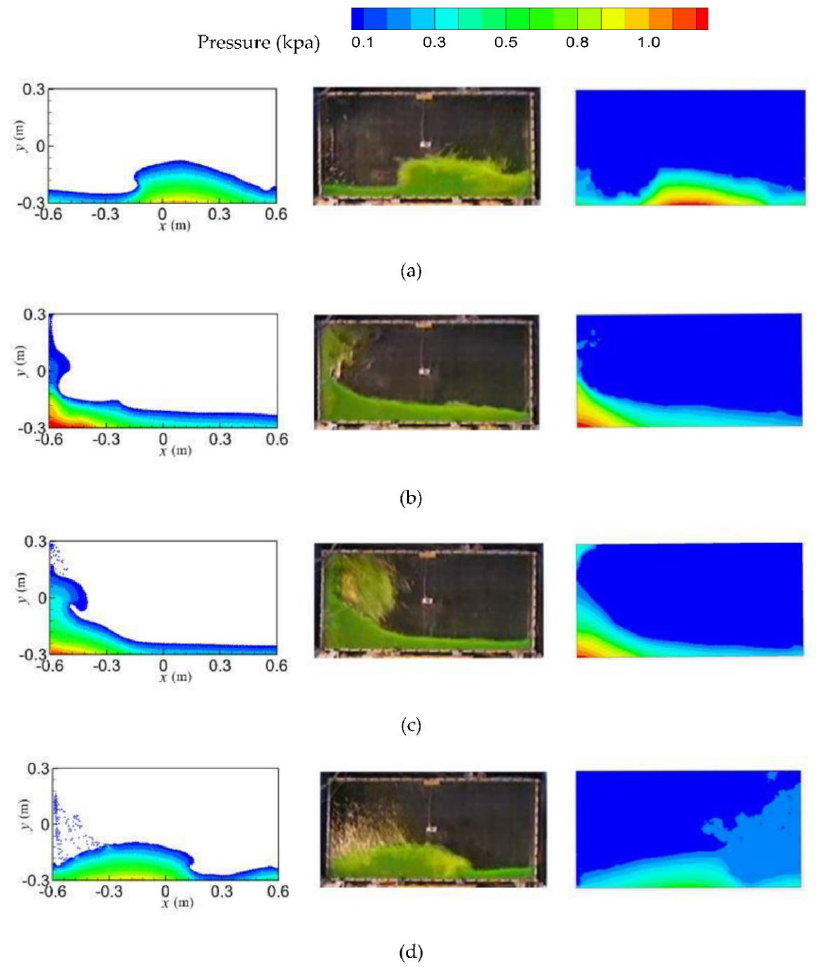
Figure 2. Sloshing patterns computed by Incompressible Smoothed Particle Hydrodynamics (ISPH) ( left ) and STAR-CCM+ ( right ), compared with experimental photos ( middle ) at time: ( a ) 0 T ; ( b ) T /6; ( c ) T /3; ( d ) T /2.